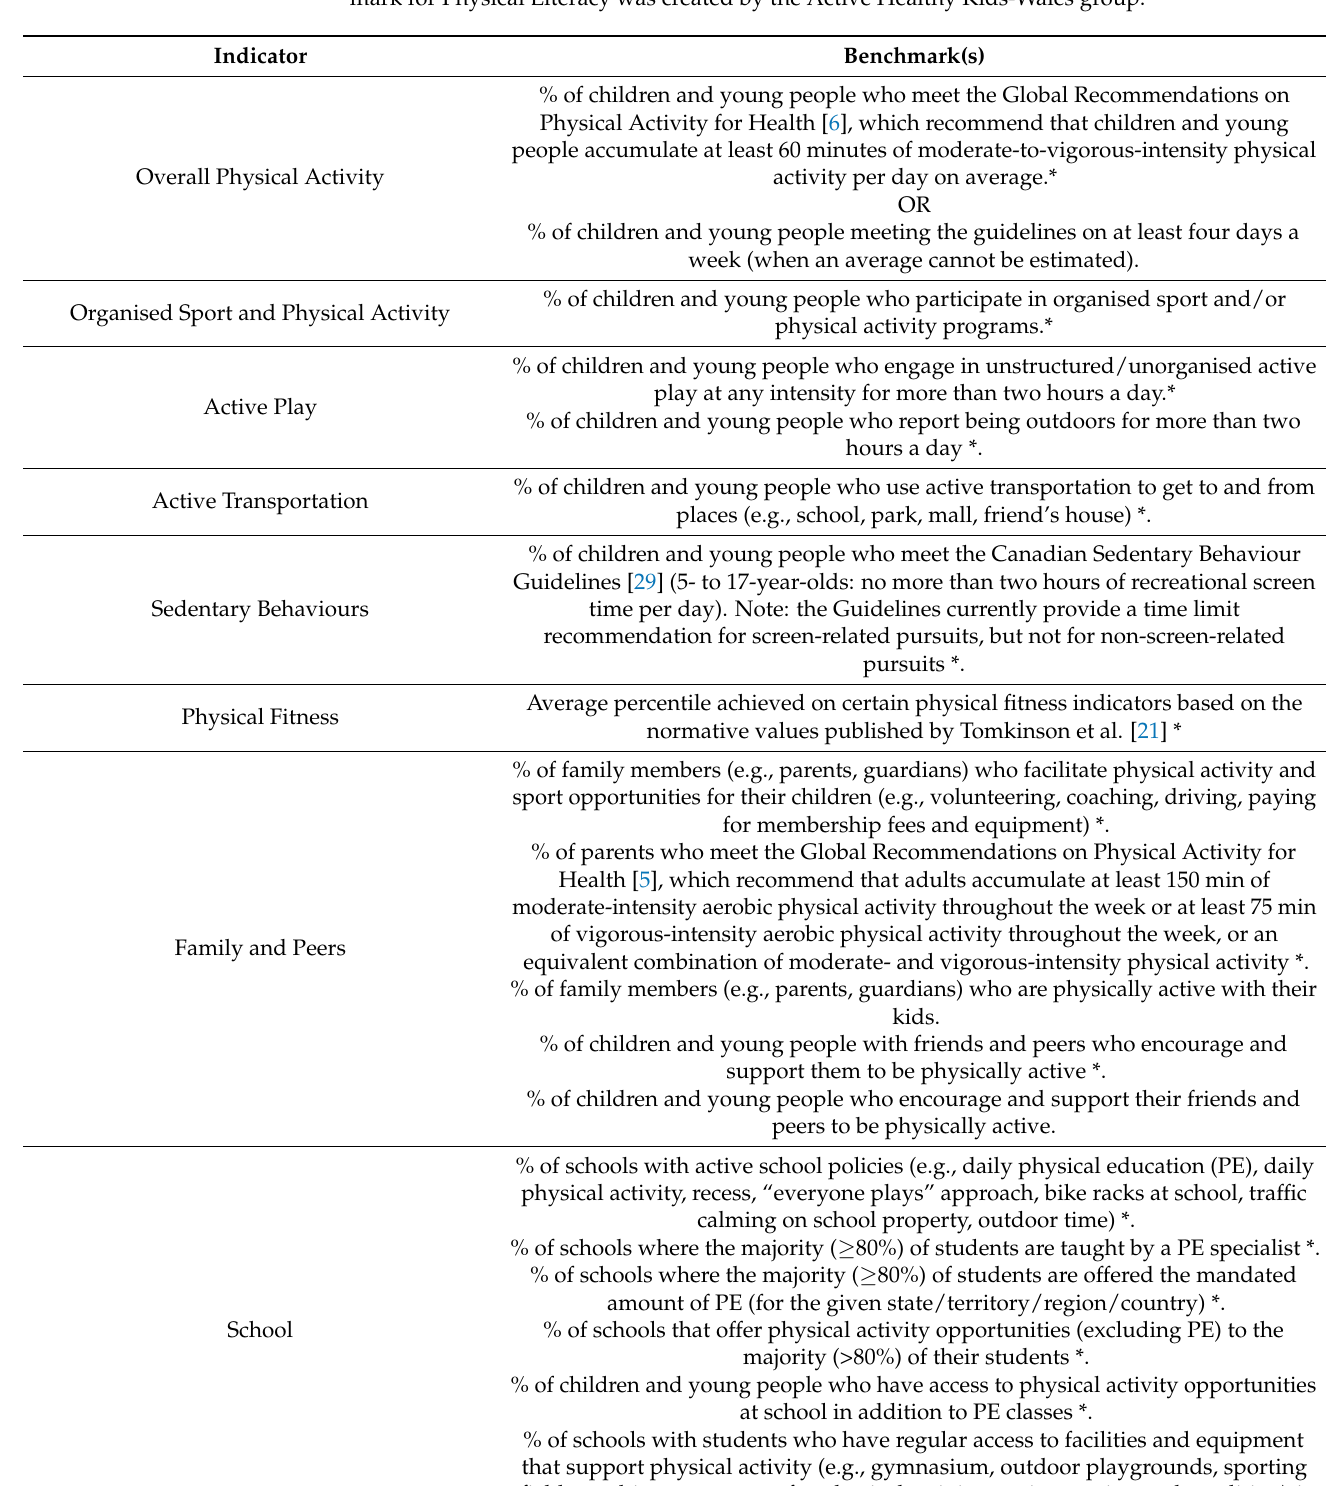
Table 1. The Active Health Kids Global Alliance benchmarks for each quality indicator. The bench- mark for Physical Literacy was created by the Active Healthy Kids-Wales